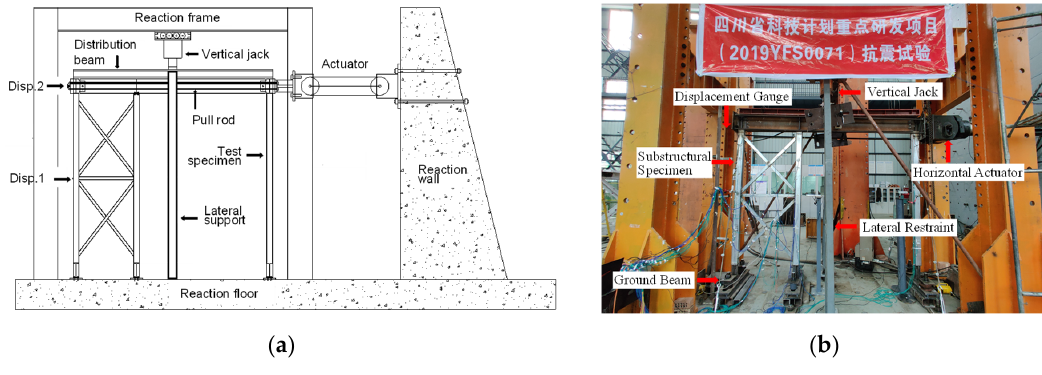
Figure 4. Test setup: ( a ) Schematic drawings; ( b ) On-site photo. The horizontal loading protocols were based on JGJ101-2015 [18] and ATC-24 [19], as shown in Figure 5. The loading rate varied based on the inter-story drift: a displacement increment of 0.04% was implemented when the story drift θ ≤ 0.2%; the displacement in- crement was 0.2% when the story drift 0.2% < θ ≤ 2.0%, and when the story drift θ > 2.0%, the displacement increment was set to 0.6% until the specimen was damaged. Figure 5. Loading protocol. 3.3. Material Properties Material properties of the steel members were obtained according to Chinese st and- ards GB/T 228-2010[20] and GB/T 2975-2018[21]. Five groups of test coupons were pre- pared to examine the actual material properties of the beams, columns, rigid bracings, and beam-to-column joints in the specimen. Tensile tests of the flexible bracings were also con- ducted. Three tests were conducted for each component member, and the average results are provided in Table 2. Table 2. Material properties of the steel members. Component Member